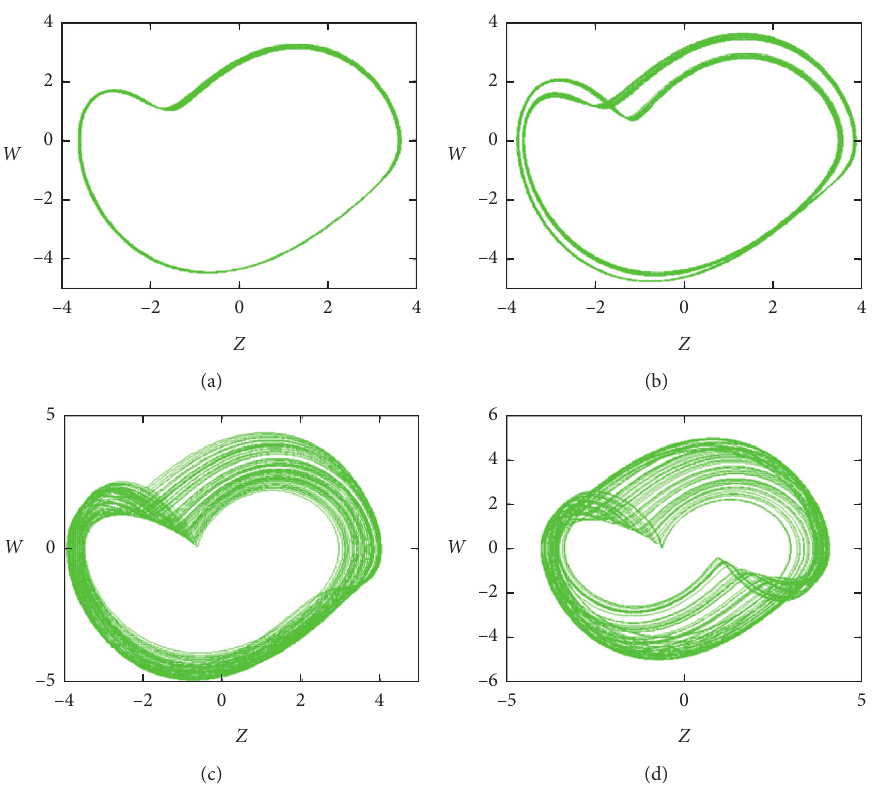
Figure 7: Phase portraits of system (1) with (a) � 0.8, (c) � 1, (d) � 0.1 and initial condition IC � (0.01, 0.01, 0, 0) on the ( z )-( w ) plane: (a) (b) � 0.55, (b) (b) � 0.52, (c) (b) � 0.5, (d) (b) � 0.4805.